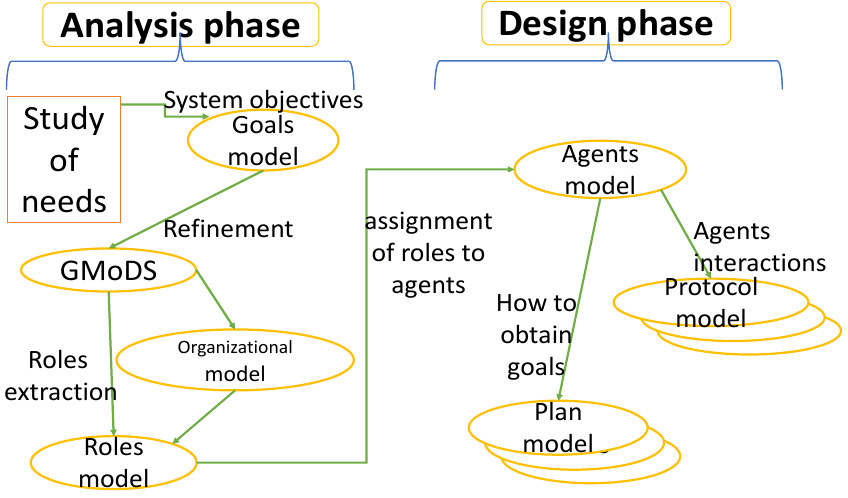
Figure 3. General Bi-phase process of O-MaSE.